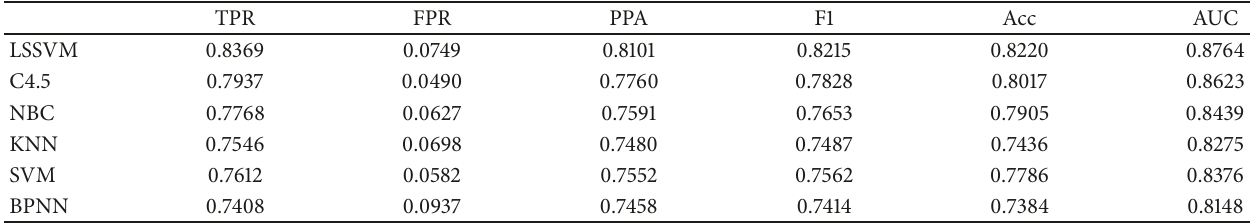
Figure 8: The AUCs of ROC curves of six classifiers for four driving anger states. Table 5: The average classification performances of the six models for four driving anger